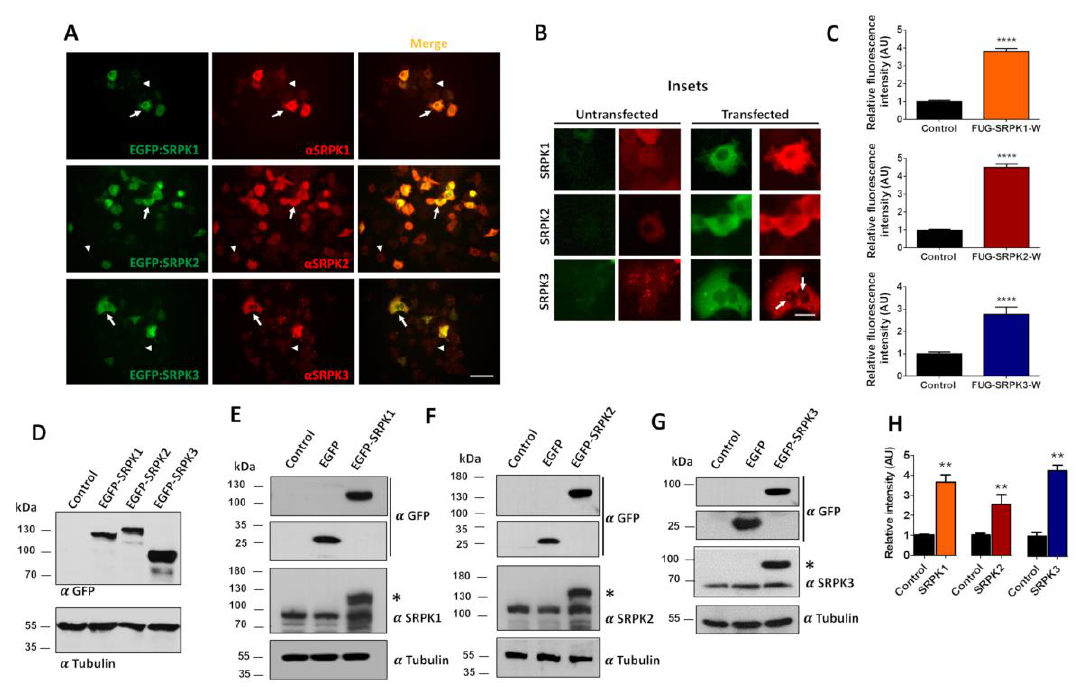
Figure 1. Characterization of SRPK1, -2 and -3 overexpression in HEK293T cells. ( A ). Representative images of cells transfected with pEGFP-SRPK1, -2 and -3 plasmids. Forty-eight hours after transfection cells were fixed and stained for SRPK1, -2 and -3 with the respective antibodies (red fluorescence). ( B ) The insets are a magnification of cells represented in A, where a diffuse pattern for the three kinases is evident, but in addition aggregates are observed for SRPK3 both in untransfected as in transfected cells. Scale bar: 5 µm ( C ) Quantification of red fluorescence intensity in non-transfected and EGFP-SRPK1, -2 and -3 transfected cells. ( D ) Western blot analysis of SRPK1, -2 and -3 overexpression. Blots were detected with anti-GFP antibody showing the respective molecular size for the EGFP-SRPK1, -2 and -3. ( E – G ) Western blots detected with kinase-specific antibodies comparing the expression and size of the EGFP-SRPKs with the respective endogenous kinases. The asterisks in these figures represent the EGFP-SRPK proteins. ( H ) Quantification of band intensity for the EGFP-SRPK proteins versus the endogenous kinases. A clear overexpression is observed with the transfection for the three kinases. The amounts of plasmid used for transfection were 0.5 µg/well (24-well plates, immunofluorescence) and 2.5 µg/well (six-well plates Western blot). Data are presented as mean ± SEM and statistical analysis was done by t -test, n = 20 cells (three independent experiments). ** p < 0.01; **** p < 0.0001. Scale bar: ( A ) 16 µm and (B ) 5 µm.